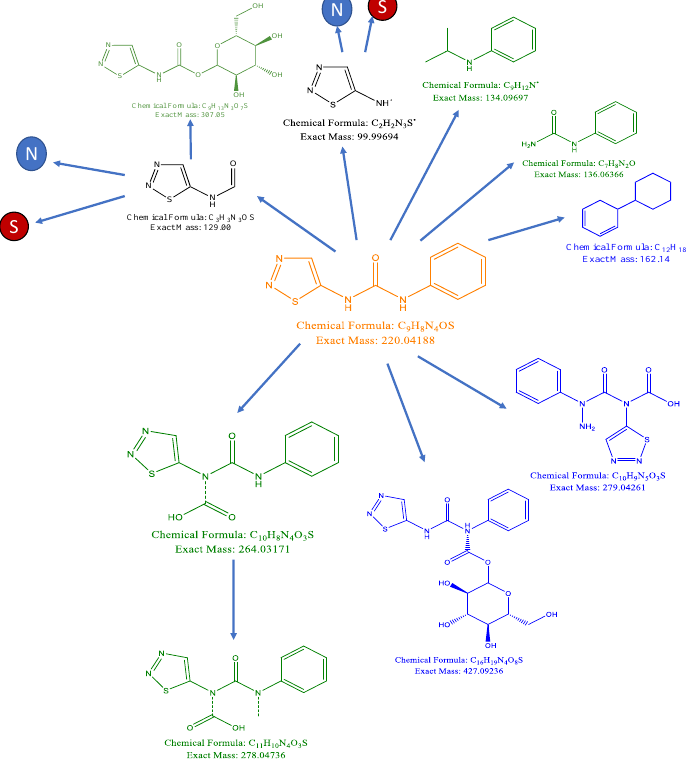
Figure 1. Thidiazuron (TDZ) metabolism in plant tissues. Orange is the TDZ parent. Blue represents features found in both low and high TDZ treatments. Green represents features found only in the low TDZ treatment. Black compounds are predicted but were not detected in the dataset. Dashed lines indicate predicted bonds consistent with the molecular features.